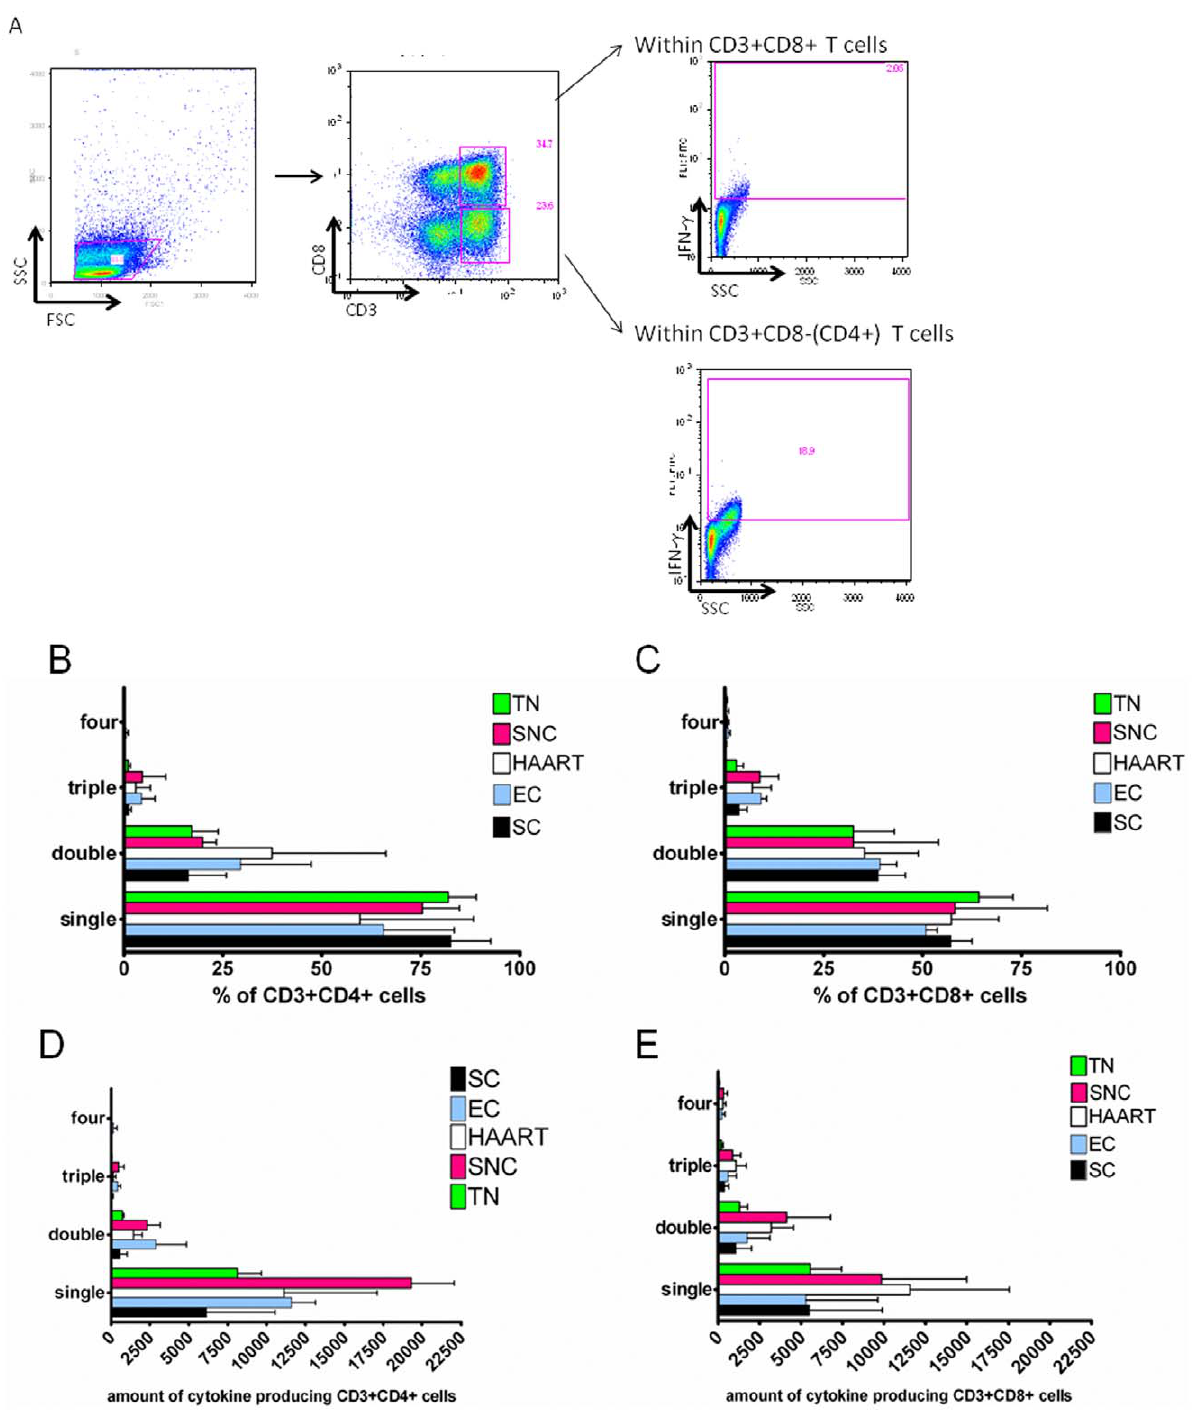
Figure 4. Evaluation of T cell polyfunctionality. PBMC from all study subjects were stimulated with peptide pools, selected for positive responses in the IFN- c ELISPOT screening in each individual separately. In A the gating strategy for identification of multifunctional CD3 + CD8 + and CD3 + CD8 2 (CD4 + ) T cell responses is shown. After physical gating the mononuclear cells and excluding the dead cells, CD3 + CD8 + T-cells and CD3 + CD8 2 (CD4 + T-cells) were identified. Within each of these populations the expression of IFN- c , IL-2, TNF-a or CD107a was plotted against side scatter, to allow Boolean gating for the ultimate quantification of polyfunctionality. Polyfunctionality was analyzed using Flowjo by assessing the percentages of CD3 + CD8 2 (hence CD4 + ) T cells (in B) and CD3 + CD8 + T cells (in C) that produce one, two, three or four cytokines. Percentages of co- expression for all selected peptide pools within one patient were summed and the mean + SD was calculated for each group. In D and E is the number of CD4 + T-cells respectively CD8 + T-cells that produce one, two, three or four cytokines presented. No statistical differences between groups were found.